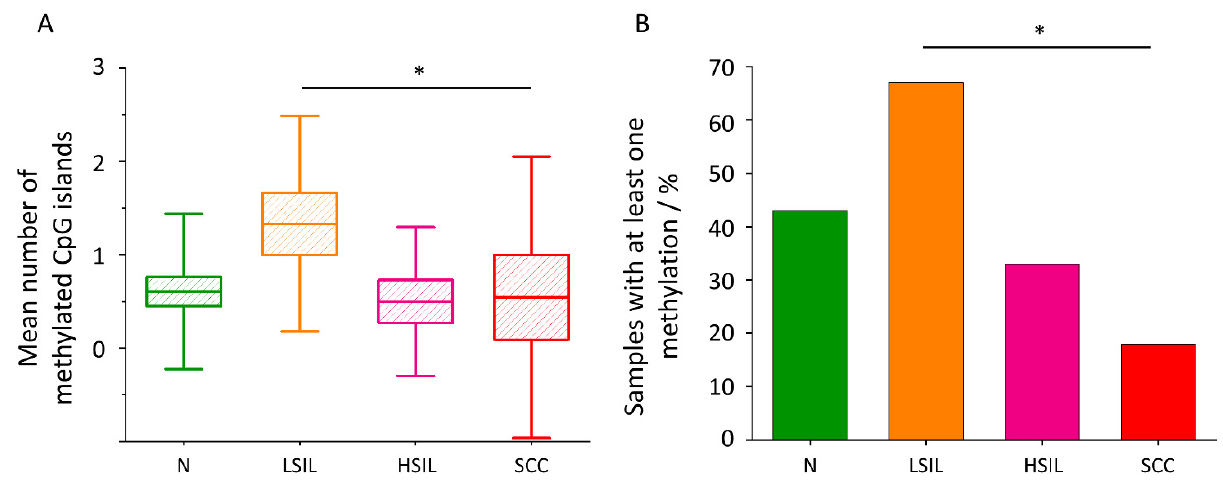
Figure 4. CpG island methylation in the SREBF1 gene. The comparison of the mean number of methylated CpG islands of the studied fragment of SREBF1 gene in the studied groups ( A ). Mean values ± SEM are given as box plots: mean (horizontal line), SEM (box), SD (whiskers). * p < 0.05. Percentage of samples with at least one methylation in the SREBF1 gene. * p < 0.05 ( B ).